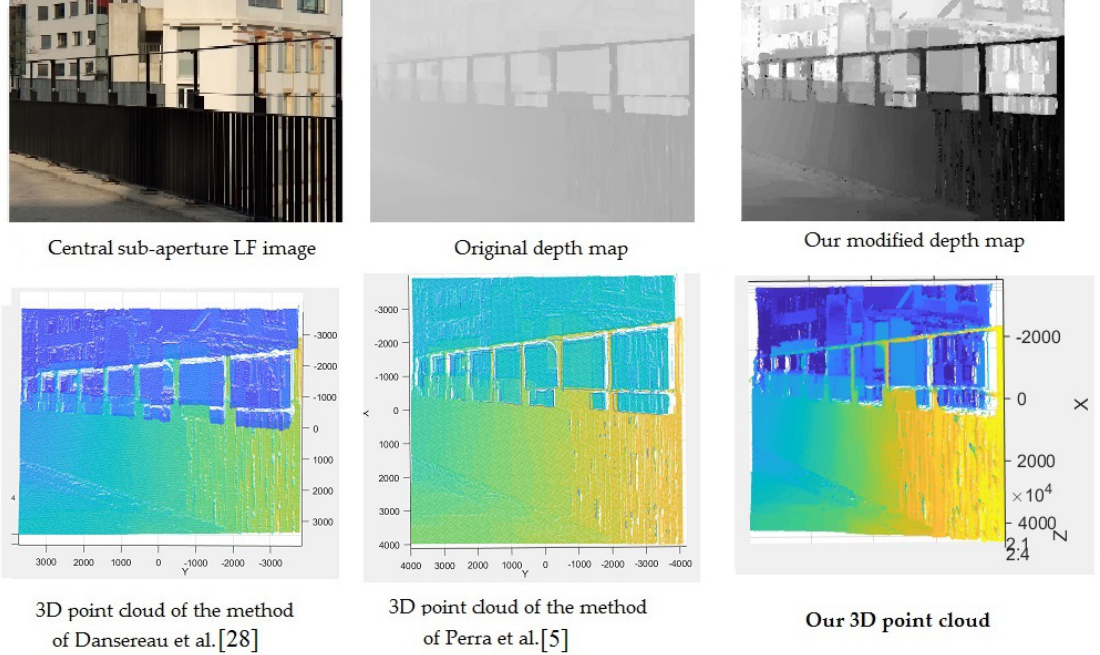
Figure 8. Comparing our result with other state-of-the-art methods. This input light field image is one of the JPEG database that is a real world LF image (Buildings-Black fence).